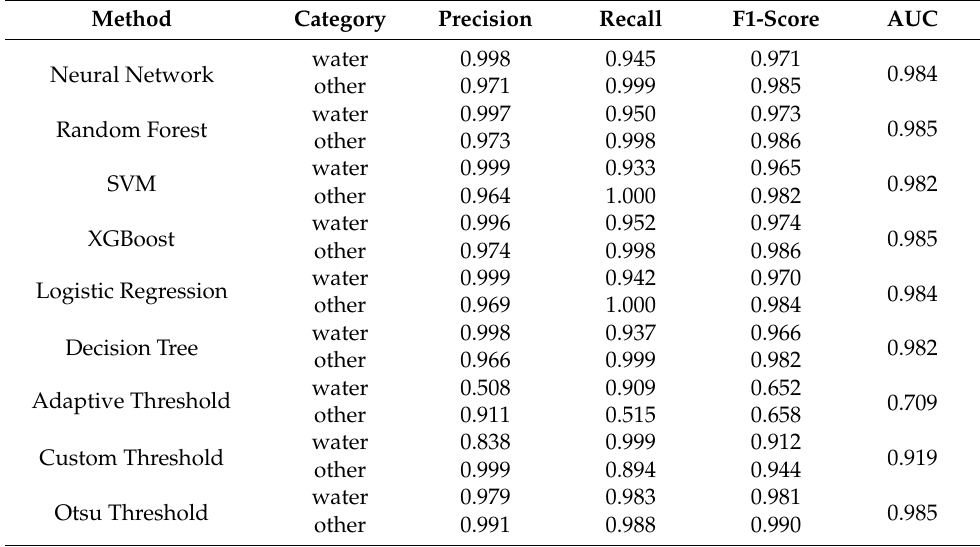
Table A2. Statistics of various indexes of each algorithm in Area1 on October